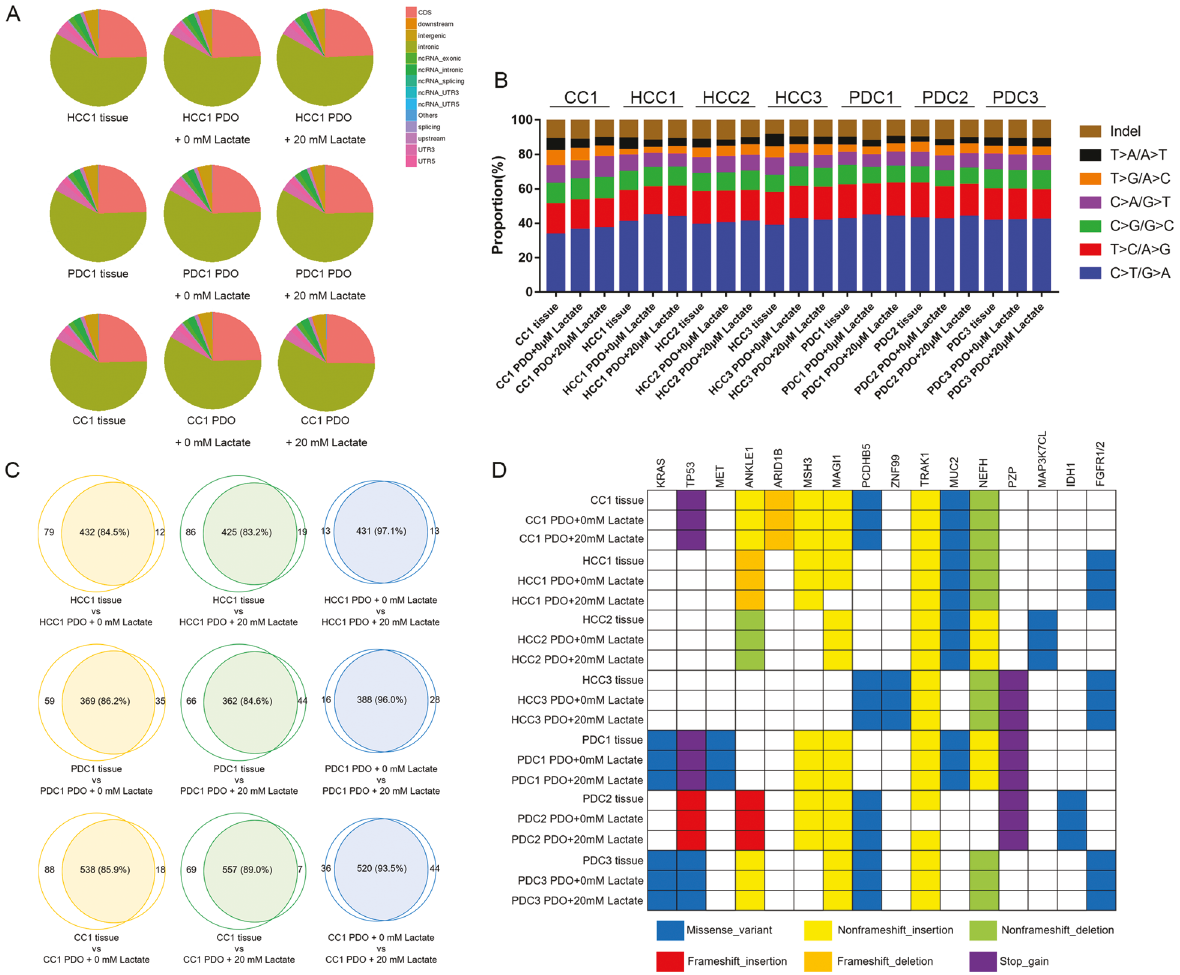
Fig. 4 Lactate maintained the genetic pro fi les of PDOs. A The number of SNPs in the different regions of the genome in original tissues and PDOs without or with 20 mM lactate treatment. The regions are shown in the legends. B The proportion of the six types of base substitutions and InDels in original tissues and PDOs without or with 20 mM lactate treatment. C The similarity of genetic pro fi les between original tissues and PDOs without or with 20 mM lactate treatment. D Representative genetic variants in original tissues and PDOs without or with 20 mM lactate treatment. The types of variants are shown in the